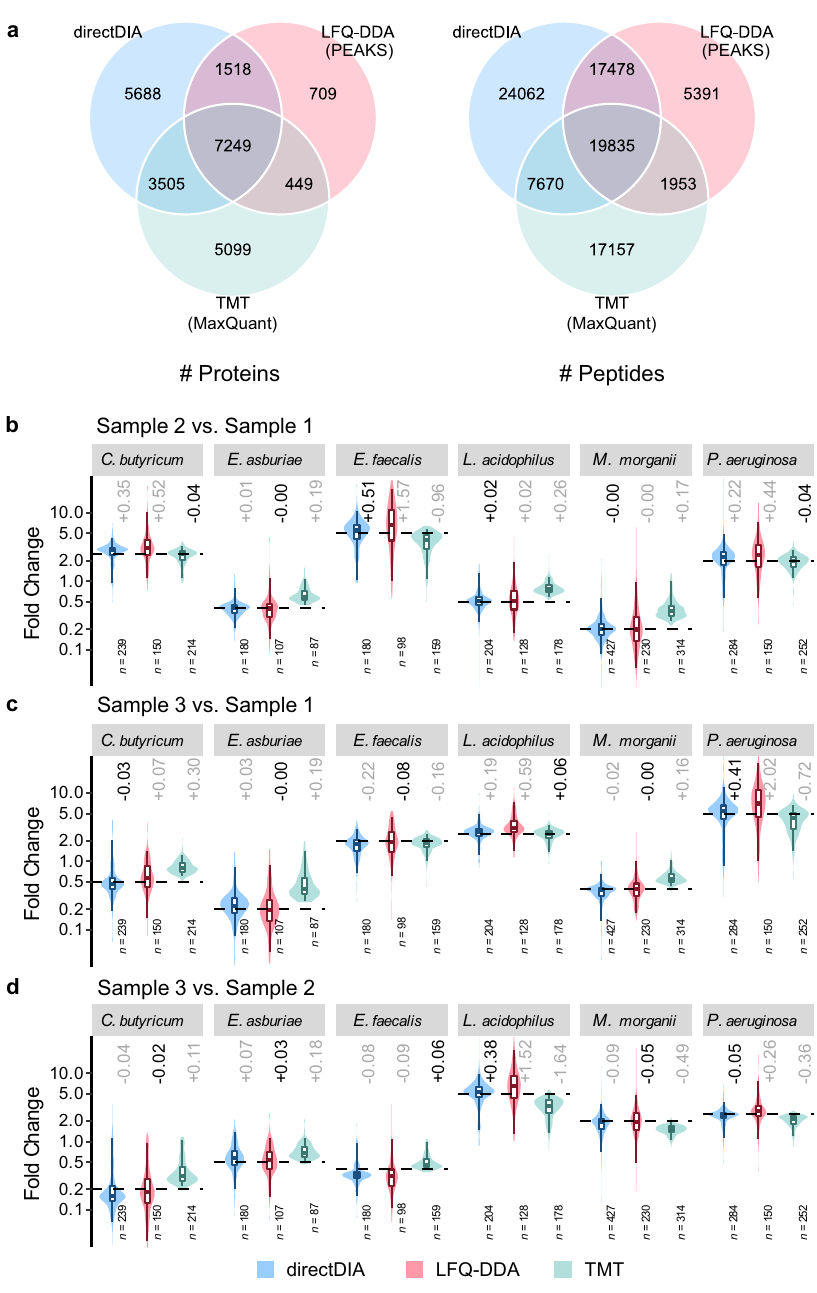
Fig. 3 Performance evaluation of directDIA, LFQ-DDA, and TMT on the spike-in metaproteome samples with 6 species added to feces. a Overlap of proteins and peptides shared in at least 2/3 replicates in each sample group by different methods. b Measured fold change (FC) values of protein abundance between sample 2 (as numerator) and sample 1 (as denominator) for each species calculated based on the average of the replicates of each sample. c Measured FC values between sample 3 (as numerator) and sample 1 (as denominator). d Measured FC values between sample 3 (as numerator) and sample 2 (as denominator). Only proteins quanti fi ed in at least 2/3 replicates of each sample group and uniquely belonging to one species were taken into consideration. Numbers ( n ) of quanti fi ed proteins are indicated for each species. The boxes mark the fi rst and third quantile and the lines inside the boxes mark the median; the whiskers mark 2.5% and 97.5% percentile; outliers are not shown. The theoretical ratios are highlighted as dashed lines. Differences between the measured median FC values and theoretical values are indicated, among which the smallest ones are darkened. The DDA data were analyzed by PEAKS, and the TMT data were analyzed by MaxQuant. Source data are provided as a Source Data fi comparisons. In the majority of the comparisons, TMT suffered performance between directDIA and LFQ-DDA on the 6 species from ratio compression that experimental median FC values spiked fecal samples is shown in Table 1. deviated from theoretical values toward a 1:1 ratio (Supplementary From the detected proteins, those uniquely belonging to the Note 4). The bias came from superposition of reporter ion intensities 6 species were selected to evaluate the quantitative accuracy of the of co-isolated and co-fragmented peptides. This phenomenon also methods (Fig. 3b – d). Among the 18 FC comparisons of the 6 species, resulted in the apparently low missing values. The spike-in TMT achieved the most accurate measurement in only 4